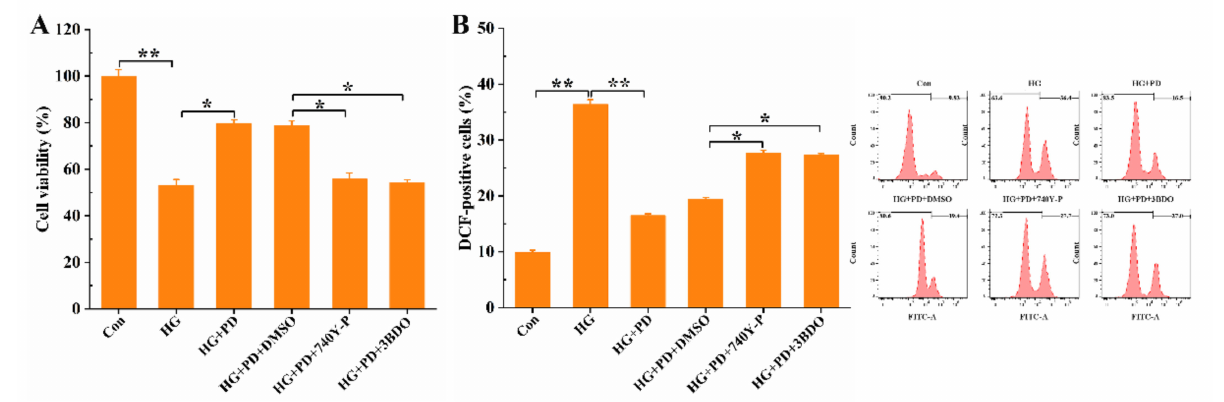
Figure 5. PD improves cell anti-inflammatory response by inhibiting PI3K/mTOR pathway. * p < 0.05, ** p < 0.01. The oral mucosal cells were treated with 740-YP (20 µ M), 3BDO (60 µ M), HG (50 mM), and PD (80 µ g/mL); the cell viability ( A ) and ROS ( B ) were detected by flow cytometer. * p < 0.05, ** p <